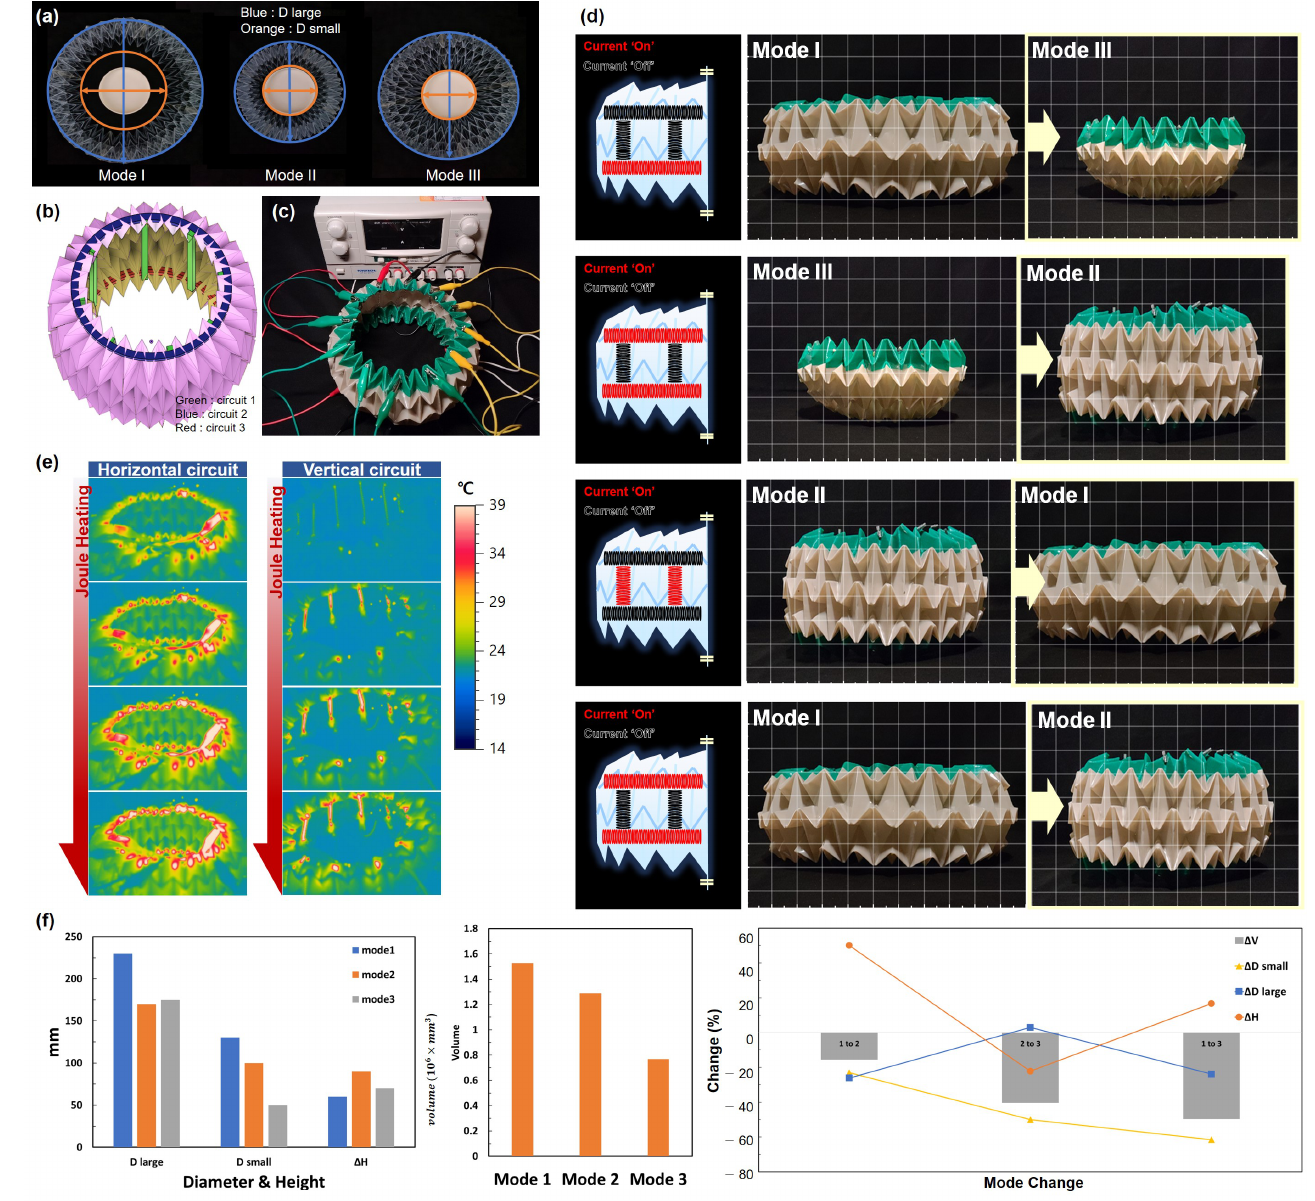
Figure 2. The deformation modes and experiments. ( a ) The three modes of deformation viewed from above. ( b ) Modeling of structure which marks the three SMA circuits. ( c ) Experimental setup for deformation. ( d ) Modes of deformation (Video S1). ( e ) Thermal images when current was applied (Video S2). ( f ) Heights and diameters in the three modes/volume by mode/diameter, height, and volume changes by mode.